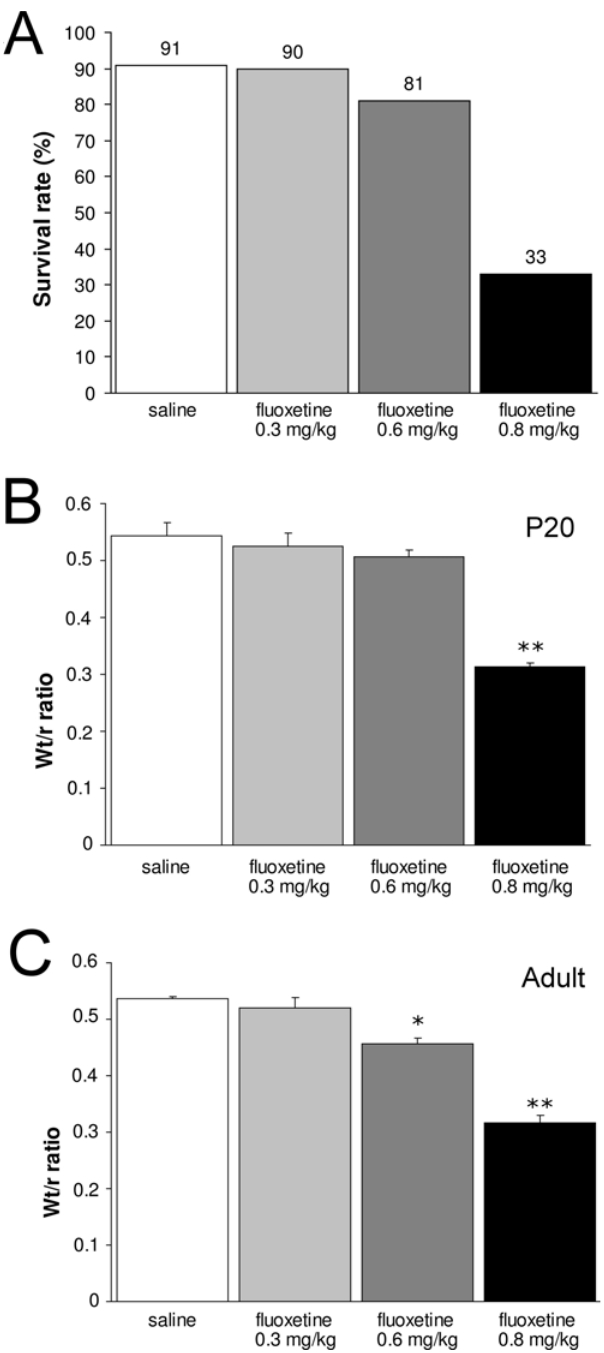
Figure 5. Survival rate and heart pathology after prenatal exposure to different doses of fluoxetine. (A) Survival rates of mice prenatally exposed to saline (white bars), 0.3 mg/kg/day fluoxetine (light gray bars), 0.6 mg/kg/day fluoxetine (dark gray bars) and 0.8 mg/kg/day fluoxetine (black bars) measured at adulthood. 67% of the offspring exposed to the highest dose fluoxetine (0.8 mg/kg/day) died during the preweaning period as compared to 9% of the saline- treated offspring. Wt/r ratios of the left ventricle are presented mean 6 S.E.M for groups treated with saline (white bars; N=5), 0.3 mg/kg/day fluoxetine (light gray bars; N=5), 0.6 mg/kg/day fluoxetine (dark gray bars; N=5) and 0.8 mg/kg/day fluoxetine (black bars; N=5) at P20 (B) and adulthood (C). Wt/r=wall thickness/radius, * p , 0.05; ** p , 0.01.